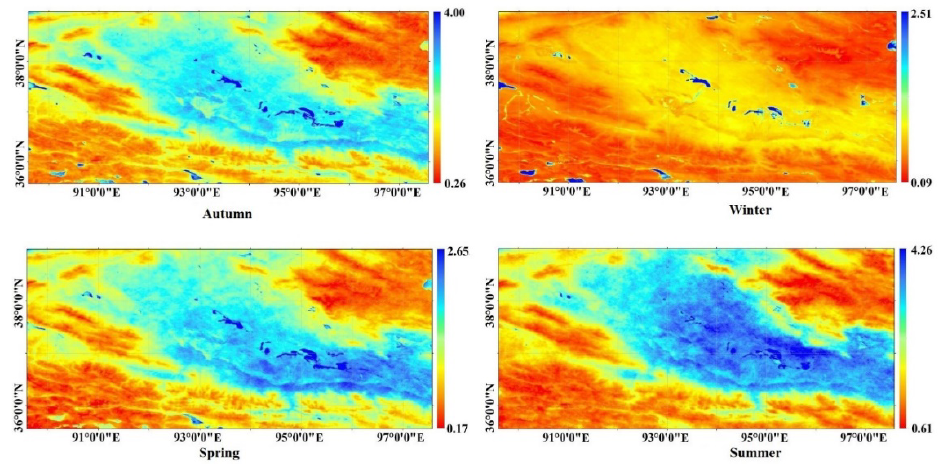
Fig. 3. 2016 (cid:794) 2019 Annual Seasonal Mean PWV Content Distribution in Lenghu Region (1*1 km 2 ).